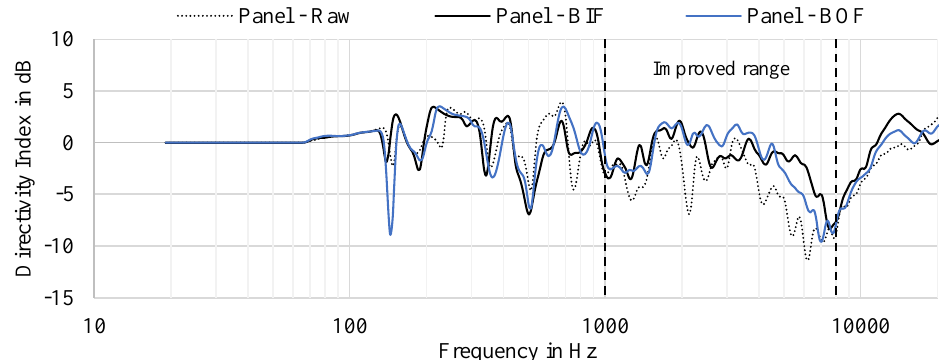
Figure 15. DI calculated as the difference in the LW ( ± 30 ◦ ) and the FH ( ± 90 ◦ ) of all three variants, namely, RAW, BIF, and BOF, measured at a 2m distance. Both, BIF and BOF constructions have flatter and lesser negative DIs.